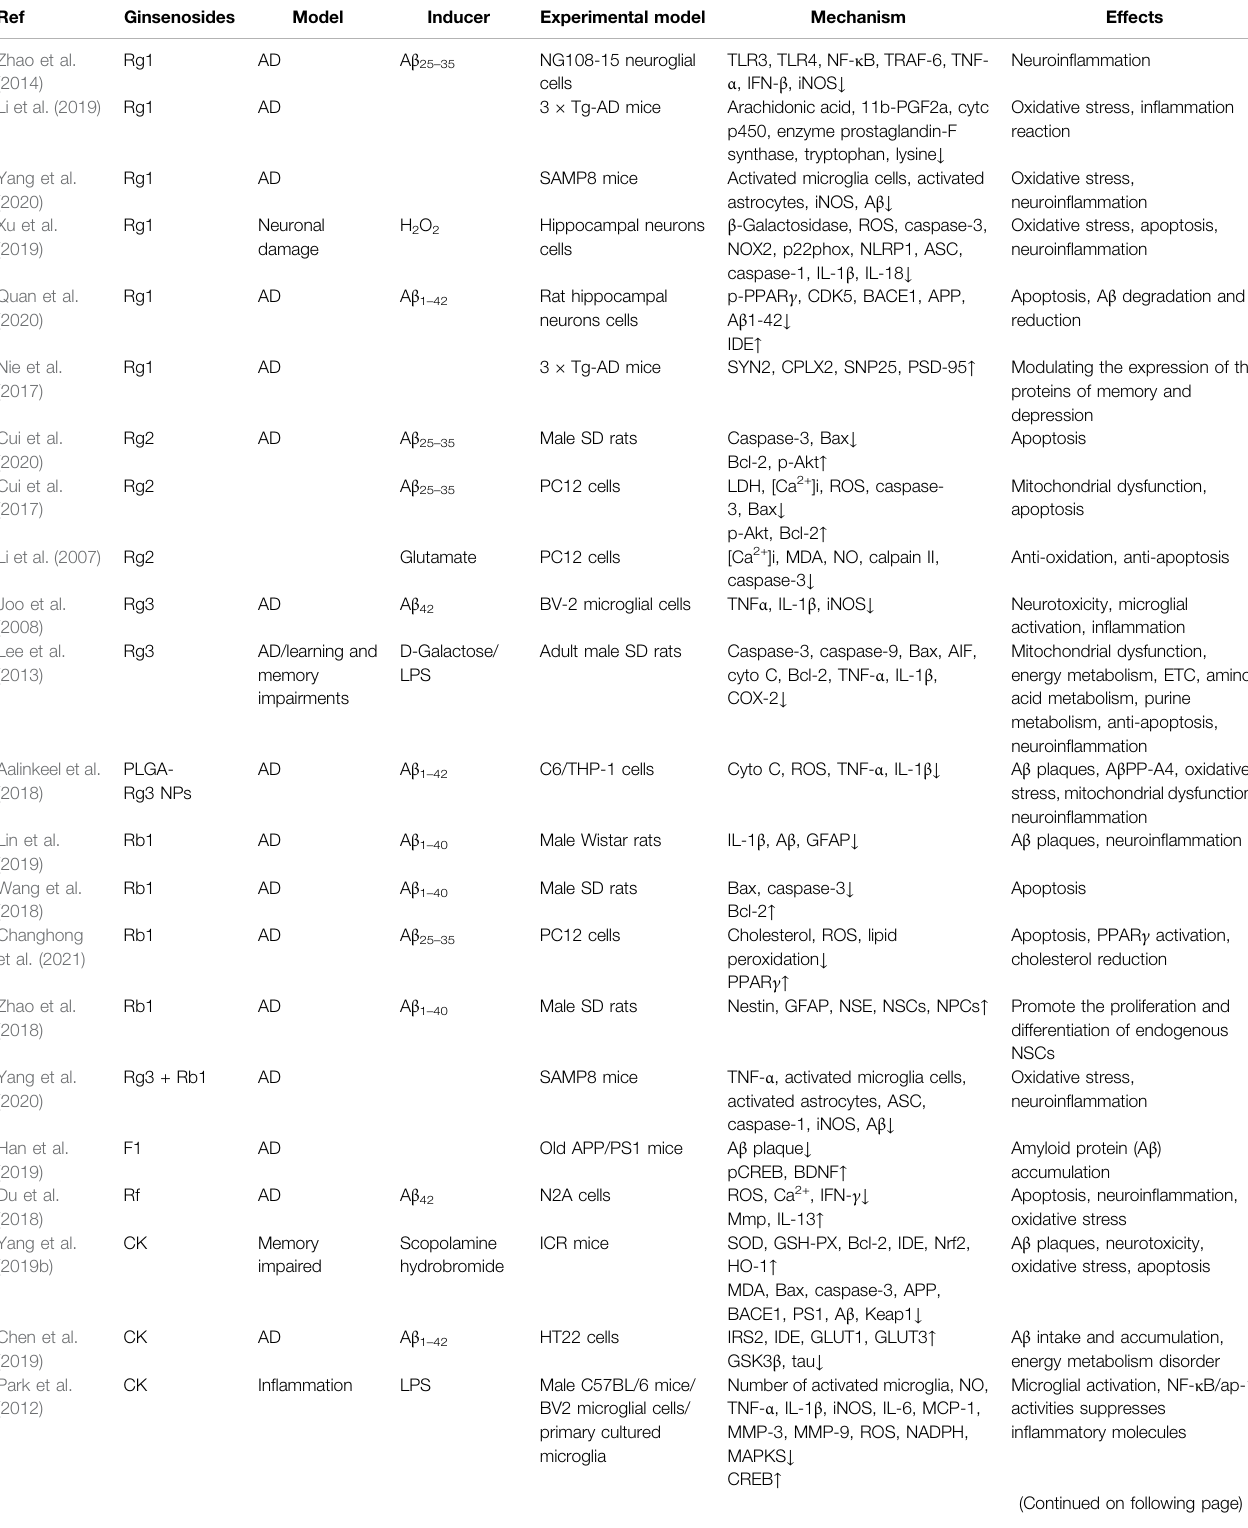
TABLE 1 | Summary of effects and mechanisms of ginsenosides in neuronal cells and animal